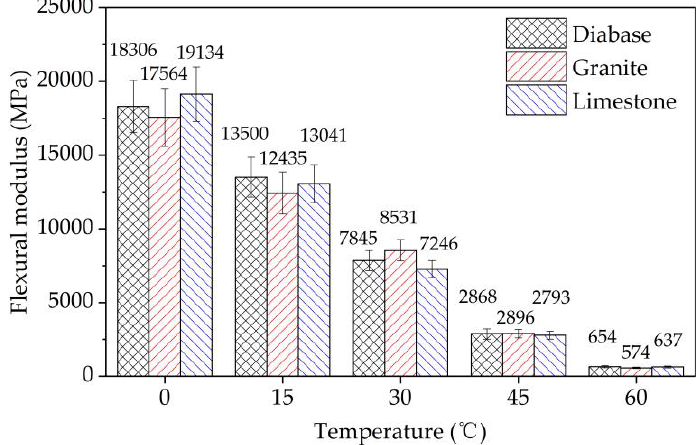
Figure 20. The initial flexural modulus in the four-point bending tests.